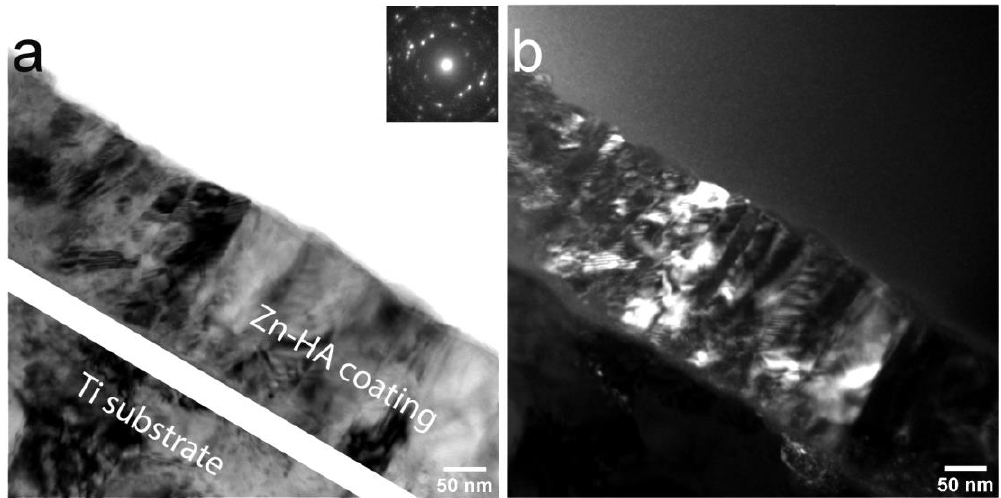
Figure 13. TEM image of the cross-section of Zn-HA coating on Ti deposited at the substrate temperature of 400 °C BF, the inset shows the corresponding electron diffraction pattern ( a ) and DF ( b ).